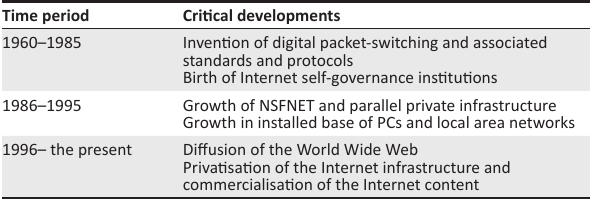
TABLE 1: The history of the